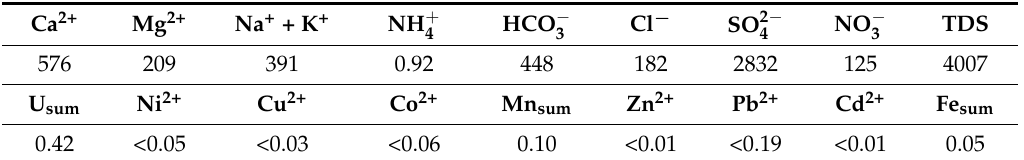
Table 1. Chemical composition of contaminated groundwater from locations near planned PRB (mg/L, pH